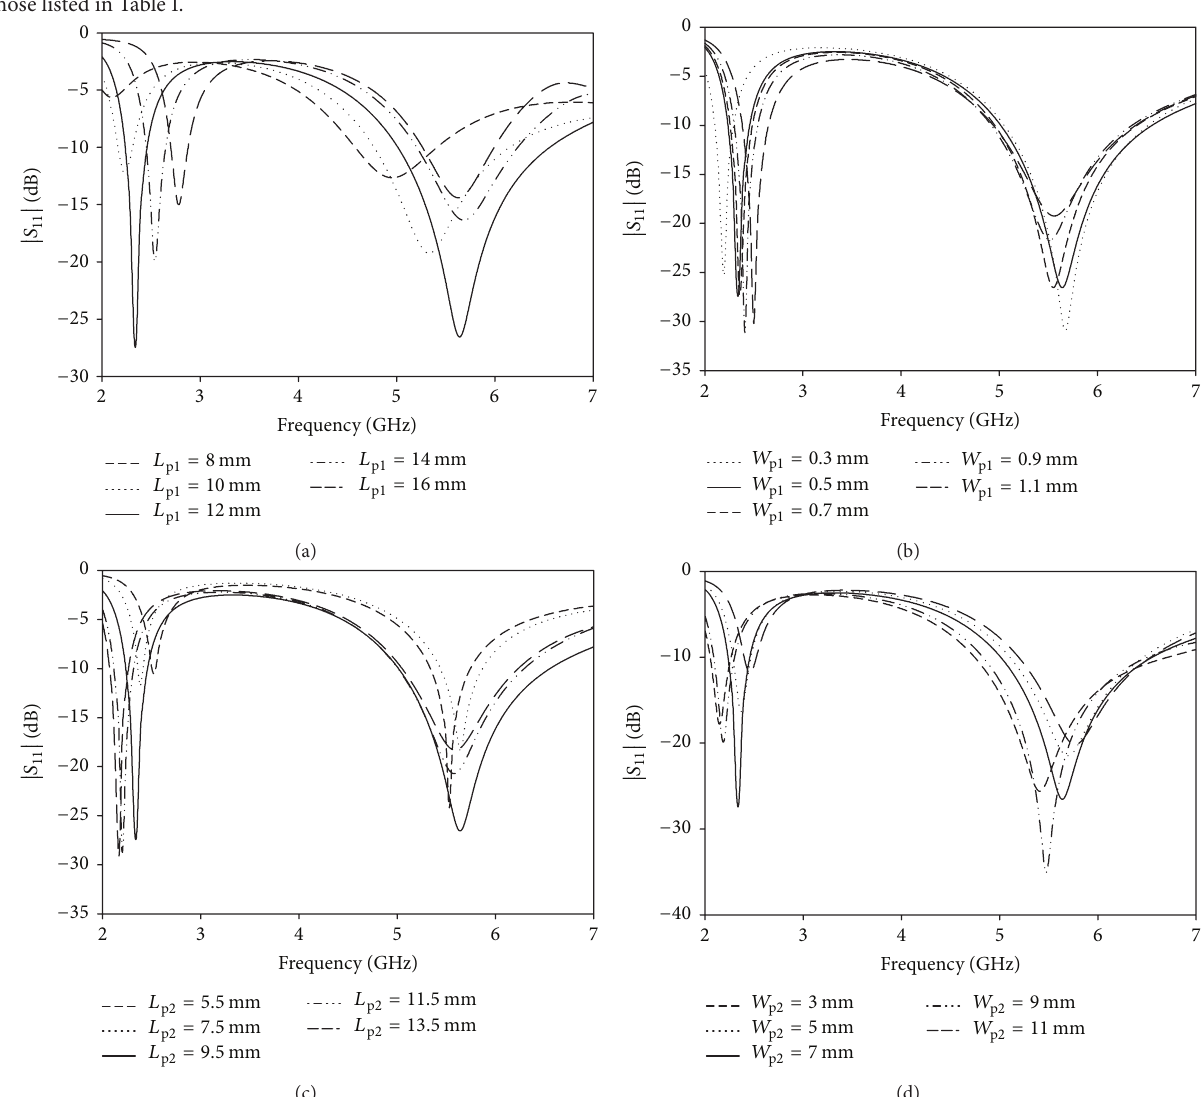
Figure 5: The effects of varying the four parameters of the parasitic resonator on the reflection coefficient of the proposed antenna. (a) 𝐿 . (c) 𝐿 . (d) 𝑊 . (In each study, the other parameters are the same as those listed in Table (b) 𝑊 p 1 p 2 p 2